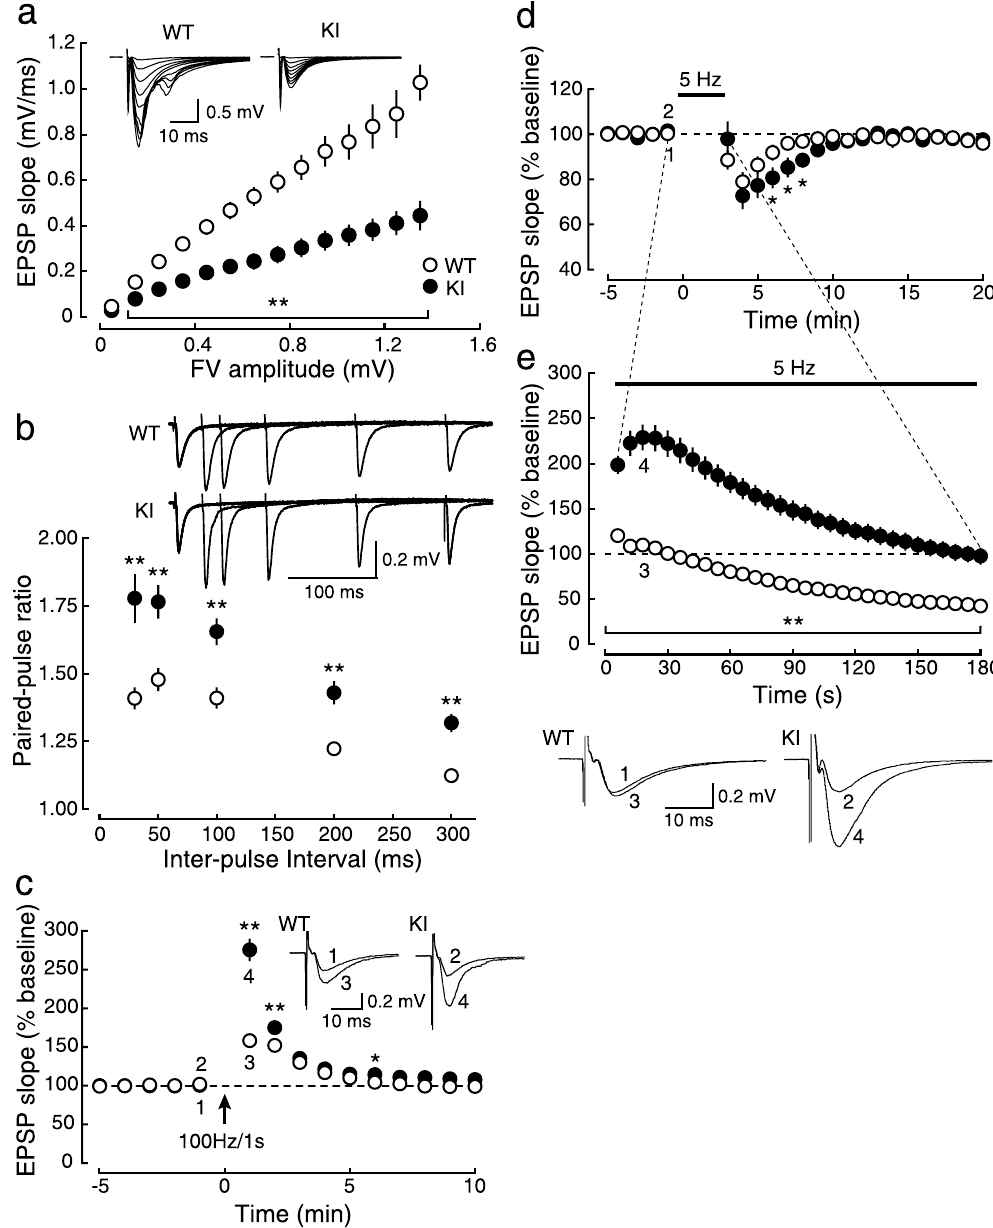
Figure 1. Abnormal basal synaptic transmission and presynaptic short-term plasticity in adult (9–15 weeks old) KI mice. ( a ) The input (fiber-volley amplitude)-output (EPSP slope) relationship of AMPA receptor- mediated EPSPs at the Schaffer collateral-CA1 pyramidal cell synapse in acute hippocampal slices of KI (closed circles: ● , n = 8) and their littermate WT (open circles: ○ , n = 9) mice. The maximum initial slope of AMPA receptor-mediated EPSPs evoked with the stimulus intensities ranging from 0.9 to 5.6 V is plotted as a function of the fiber volley amplitude. Sample traces of EPSPs (averages of 10 consecutive sweeps) evoked with various stimulus strengths are shown in the inset. ( b ) PPF (the ratio of slopes of the second EPSP to those of the first EPSP) shown as a function of inter-pulse intervals in the presence of 25 μ M D-APV (WT, open circles: ○ , n = 13; KI, closed circles: ● , n = 10). In the inset, sample traces of synaptic responses evoked by paired stimuli at intervals of 30, 50, 100, 200 and 300 ms are superimposed. ( c ) The time course of PTP elicited by tetanic stimulation (100 Hz, 1 s) in the presence of 50 μ M D-APV (WT, open circles: ○ , n = 12; KI, closed circles: ● , n = 10). Sample traces of synaptic responses during the baseline and at the peak of the potentiation at the time points indicated by the numbers in the graph are shown in the inset. ( d , e ) After obtaining a stable baseline at 0.1 Hz at least for 20 min ( d ) (only the data of the last 5 min are shown), 5-Hz stimulation was applied for 3 min ( e ), and then the stimulus frequency was returned to 0.1 Hz ( d , 3–20 min) (WT, open circles: ○ , n = 11; KI, closed circles: ● , n = 10). Sample traces of synaptic responses during the baseline and 5-Hz stimulation at the time points indicated by the numbers in the graph are illustrated below the graph. For clarity, stimulus artifacts are truncated in all sample